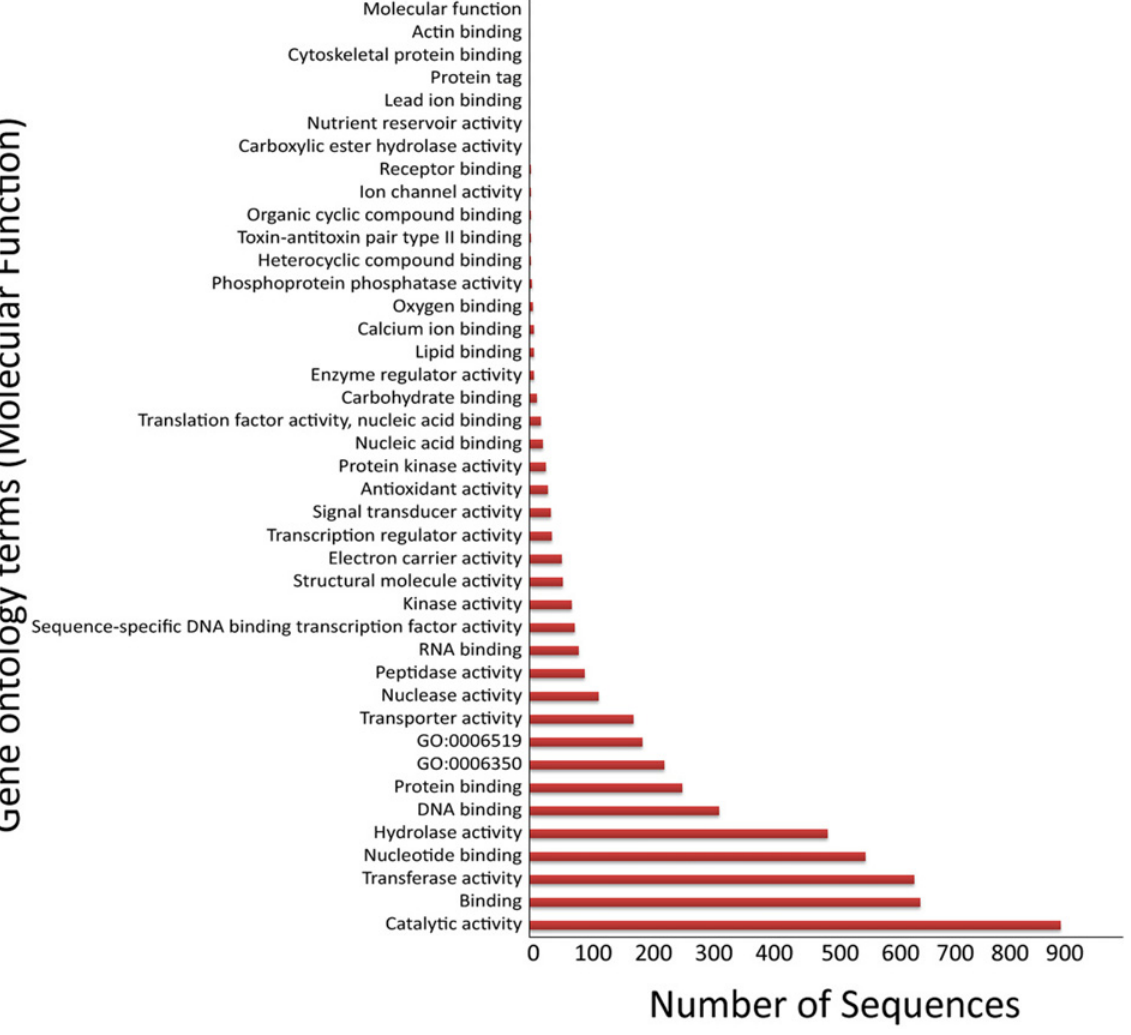
Fig 4. Molecular function GO annotations of the soft-core component. GO annotation for Biological process and Cellular component is provided in S5 and S6